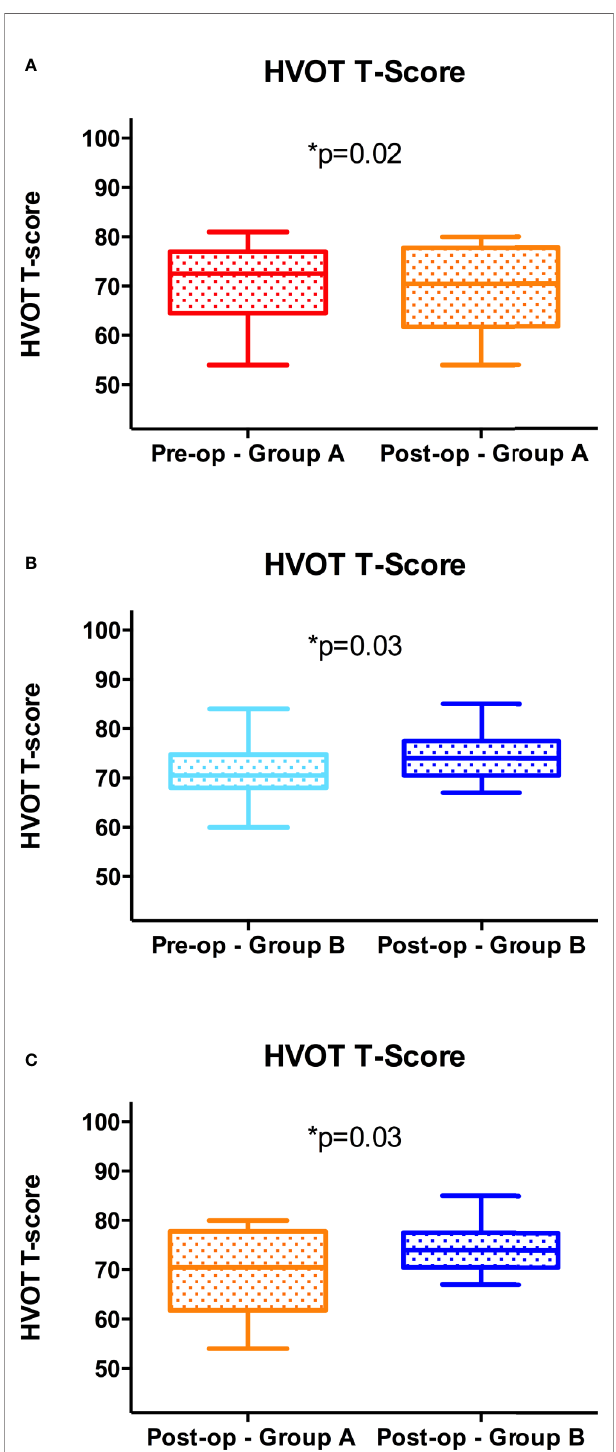
FIGURE 10 | Visuospatial outcome at one month from surgery. Signi fi cant reduction of the postoperative vs. preoperative T Score at the HVOT in Group A (A) ; signi fi cant increase of the postoperative vs. preoperative T Score at the HVOT in Group B (B) ; signi fi cant reduction (improved VSA) of the postoperative T Score at the HVOT in Group A vs. Group B (C)